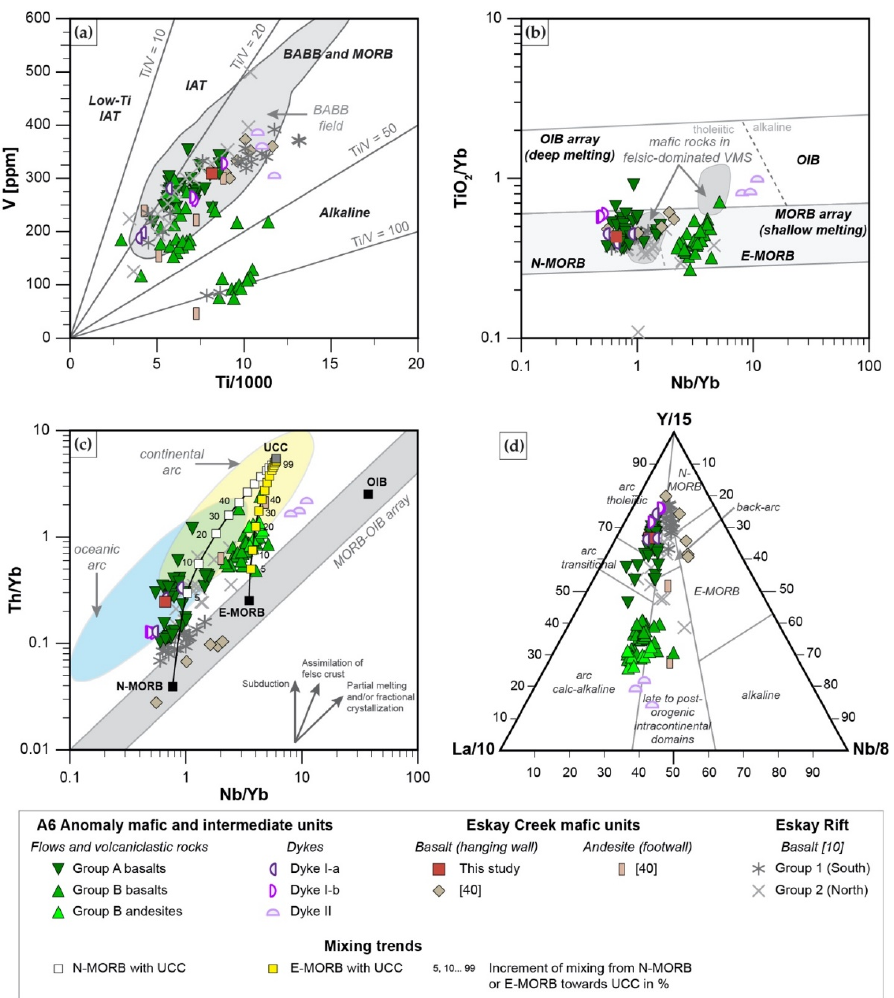
Figure 21. Discrimination of mafic lithologies at A6 Anomaly and Eskay Creek, ( a ) Ti vs. V plot [89] showing tectonic setting of basalts and dolerites, field for back-arc basin basalts (BABB) highlighted in grey, ( b ) Nb/Yb vs. TiO 2 /Yb biplot [90] discriminating between different melting sources for mafic rocks, ( c ) Nb/Yb vs. Th/Yb biplot [87] discriminating tec- tonic setting of mafic and intermediate rocks with mixing lines between N-MORB and UCC (white squares) and E-MORB and UCC (yellow squares), N-MORB, E-MORB and OIB composition from [58] and UCC composition from [88], ( d ) La- Yb-Nb ternary plot [91] discriminating tectonic setting of mafic and intermediate rocks, See text for details. Note: Group A basalts from the A6 Anomaly and Group 1 basalts from the Eskay rift [10] are almost identical in their composition and hence overlap in particular in ( b , d ) resulting that data of Group 1 basalts are partially obscured by Group A basalts since focus is on lithologies of A6 Anomaly. Abbreviations: BABB—back-arc basin basalt, E-MORB—enriched mid-ocean ridge basalt, IAT—island arc tholeiite, N-MORB—normal mid-ocean ridge basalt, OIB—ocean island basalt, UCC—upper con- tinental crust.